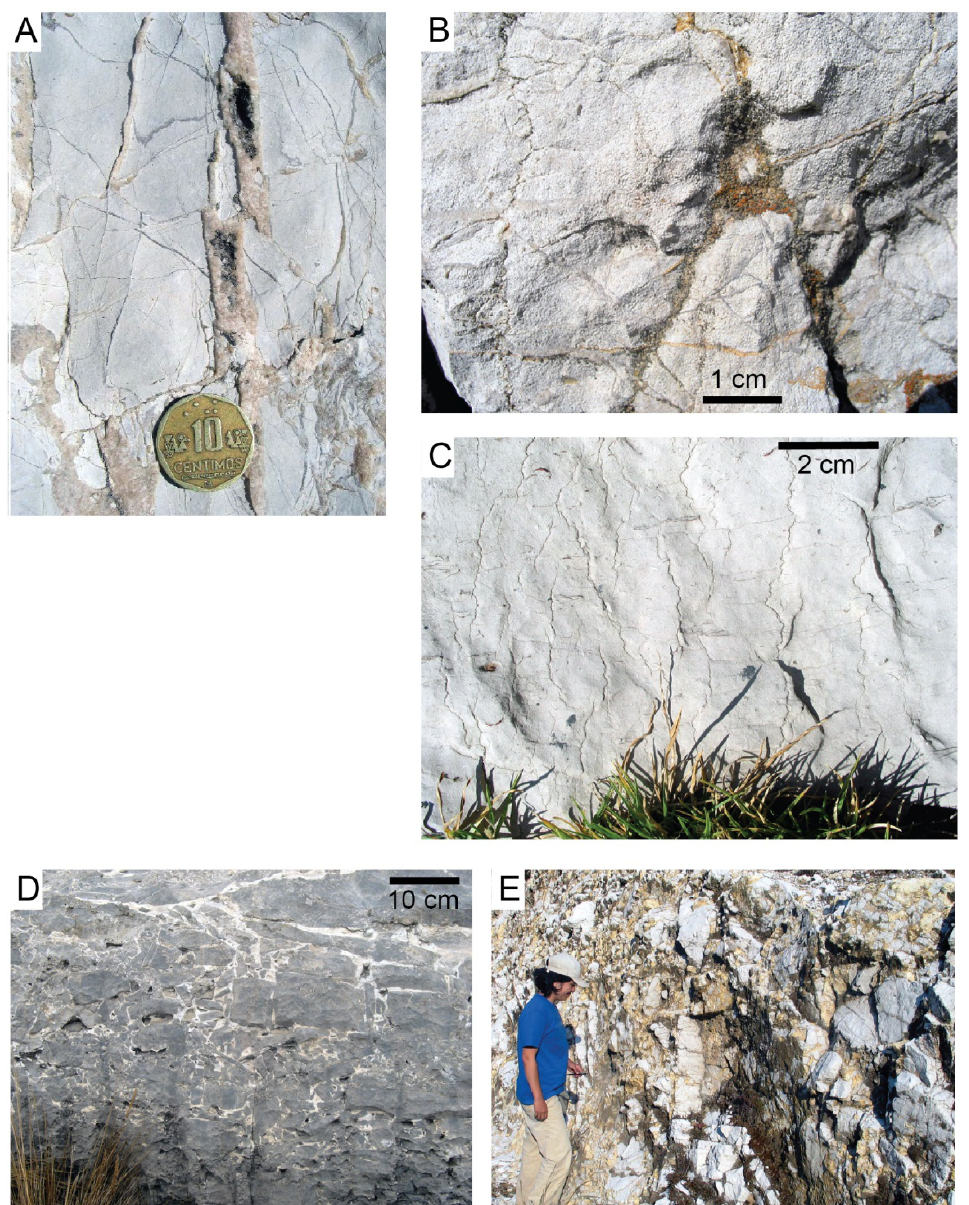
Figure 21. Deformation style at outcrop to hand-specimen scale. ( A ) Multiple veining in limestone of Pucará Group near Tarma (11°24.4' S, 75°49.1' W); ( B ) Jurassic olithic limestone near Tarma with oolites lacking any shape preferred orientation (11°27.3' S, 75°48.5' W); ( C ) Stylolites in limestones of Jumasha Formation near La Oroya (11°31.0' S, 75°55.25' W); ( D ) Brecciated limestone of the Chaucha Formaton in the core of an anticline (Saturn Anticline in Figure 10) SW of Huancayo (12°14.5' S, 75°38.3' W); ( E ) Brecciated carbonates of Pucará Group in the core of an anticline between Tarma and La Oroya (11°23.3' S, 75°51.1'